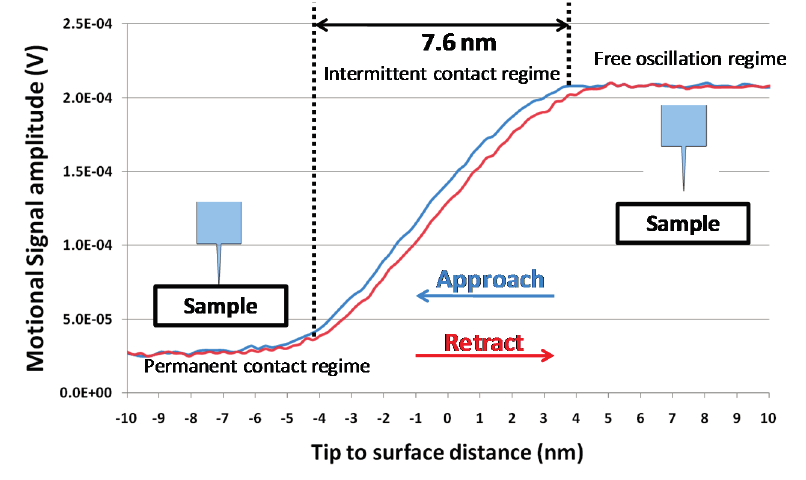
Figure 12. Demodulated signal amplitude as a function of the tip-to-surface distance. The probe was driven by a 3 V DC voltage and 1.23 V AC voltage at 5.43